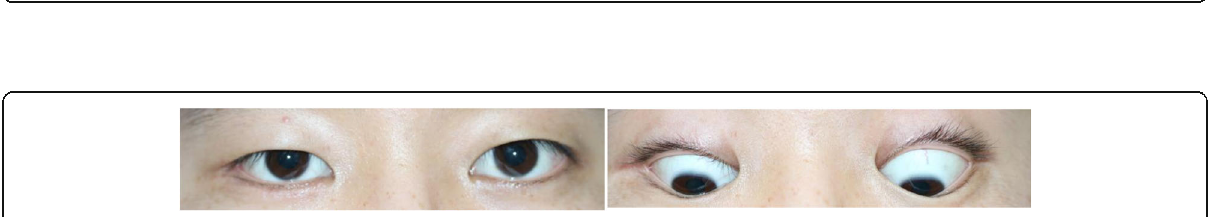
Fig. 5 a Postoperative CT images (coronal and axial sections) showing retrobulbar hematoma (yellow arrows) and proptosis (brown arrow). b Severe proptosis and chemosis are shown. c Postoperative (cantholysis and hematoma drainage) CT showing improved proptosis and reduced hematoma. d Two weeks after postoperative (cantholysis and hematoma drainage) CT